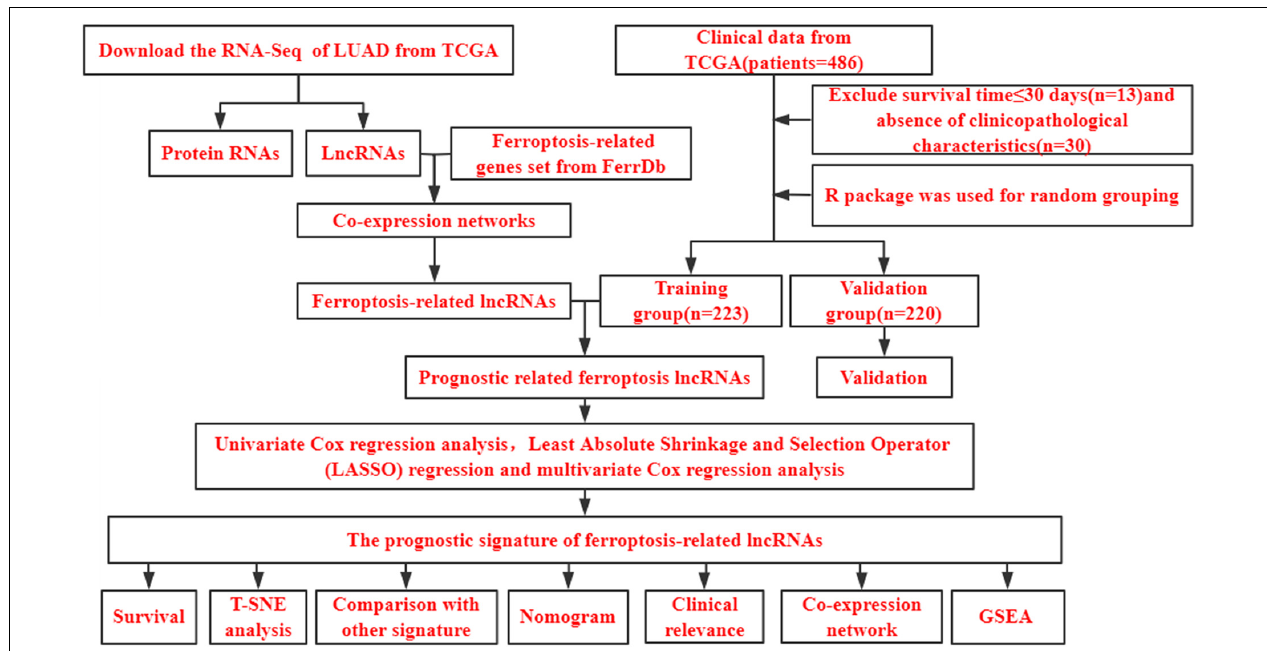
FIGURE 1 | Study flow chart. LUAD, lung adenocarcinoma; TCGA, The Cancer Genome Atlas database; lncRNAs, long non-coding RNAs; T-SNE, t-distributed stochastic neighbor embedding; GSEA, gene set enrichment analysis.